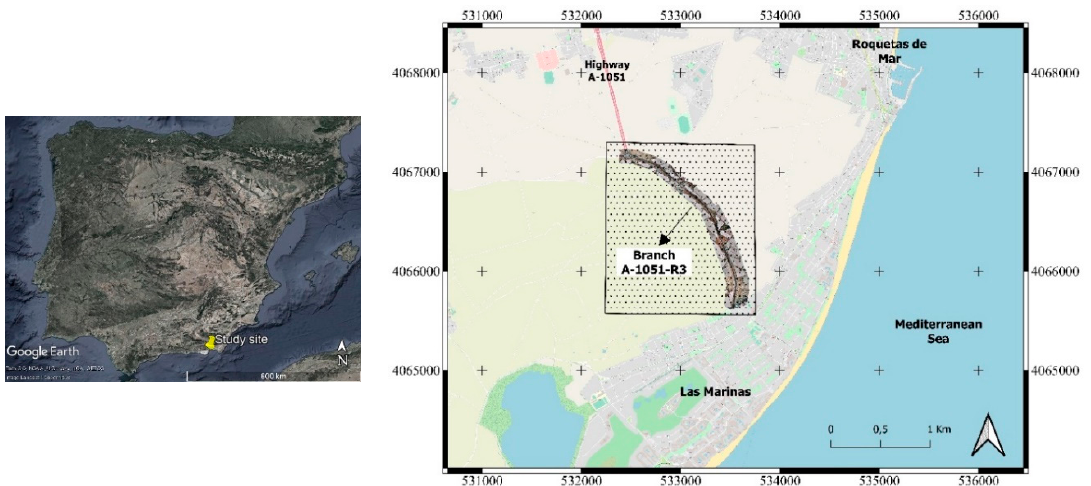
Figure 2. Location of the study site. Coordinates refer to UTM Zone 30N (ETRS89, EGM08 geoid model). The map of the Iberian Peninsula was extracted from Google Earth. The background map on the right side was extracted from OpenStreetMap, and the square inset is an orthophoto of the study site.